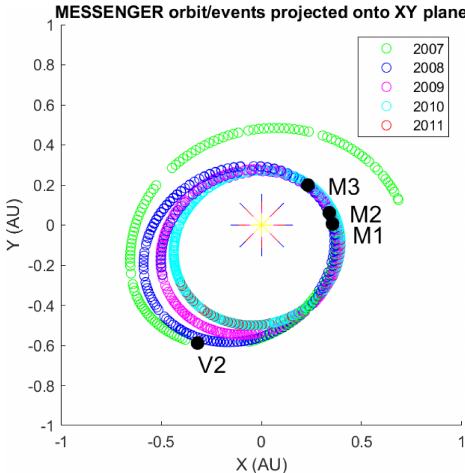
Figure 1. The cruise phase of MESSENGER projected onto the XY J2000 plane with different colours for different years and the lo- cations of the second Venus flyby (V2) and the three Mercury flybys (M1/2/3). The circles denote the locations at which magnetic holes are